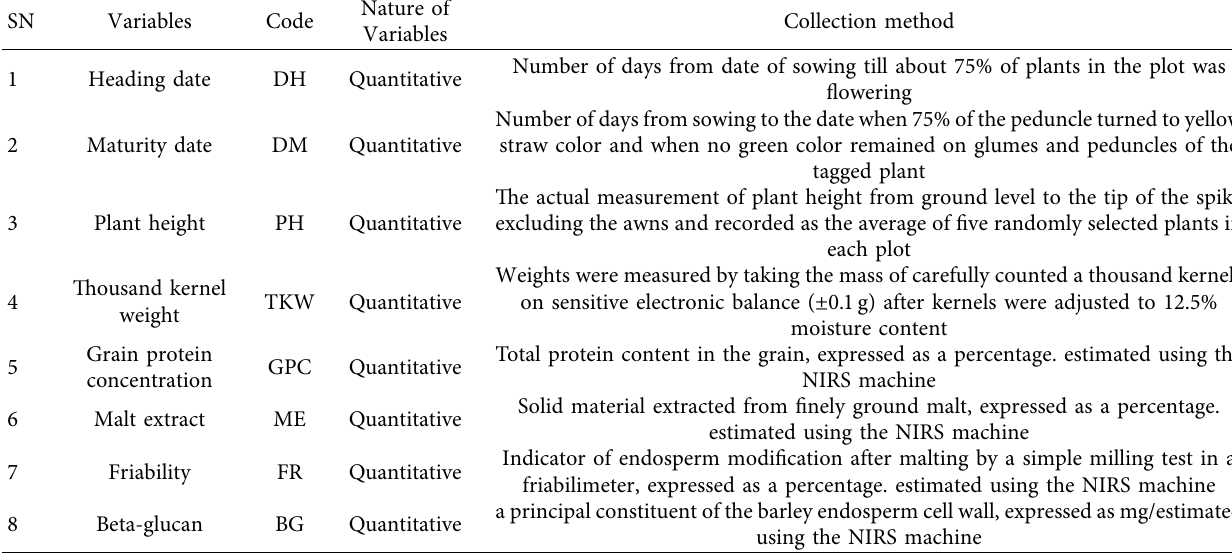
Table 2: List of agronomic and quality parameters